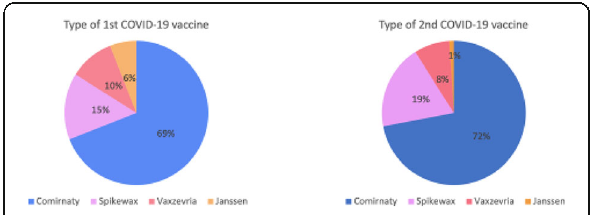
Fig. 1 (abstract P79). Type of COVID-19 vaccine administered as 1 st and 2nd